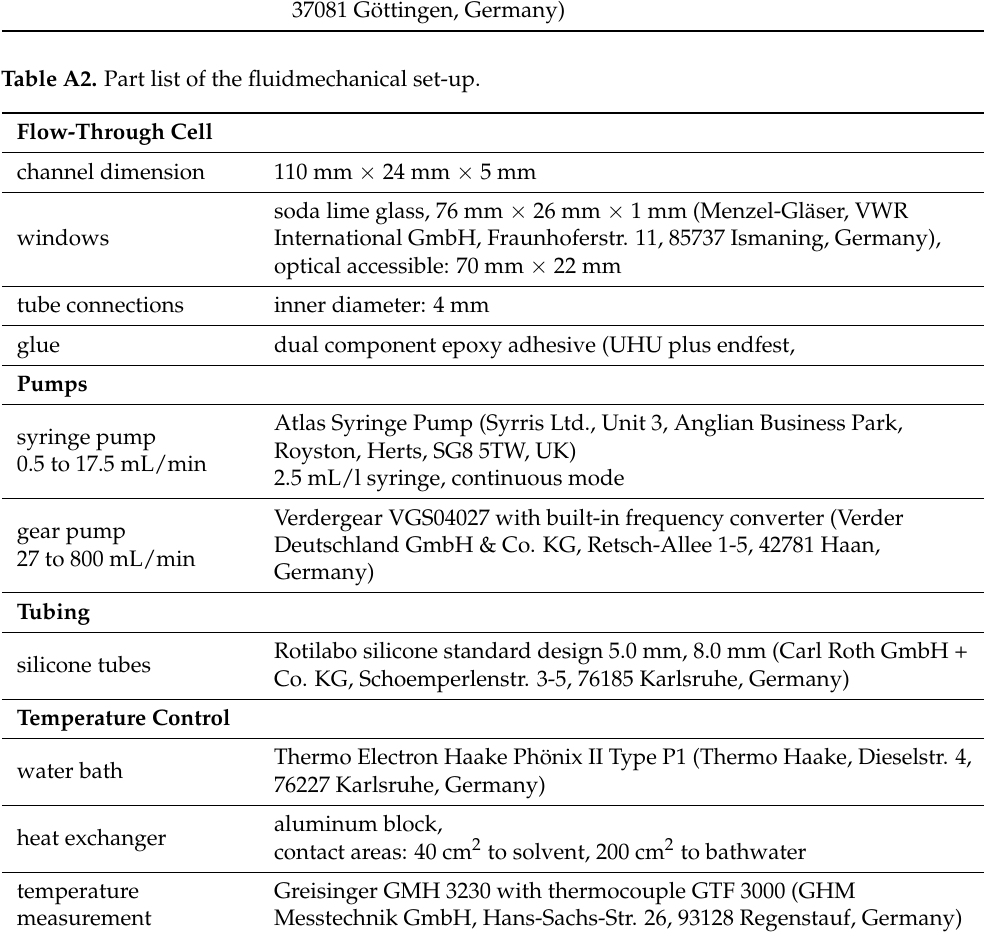
Table A2. Part list of the fluidmechanical set-up. Flow-Through